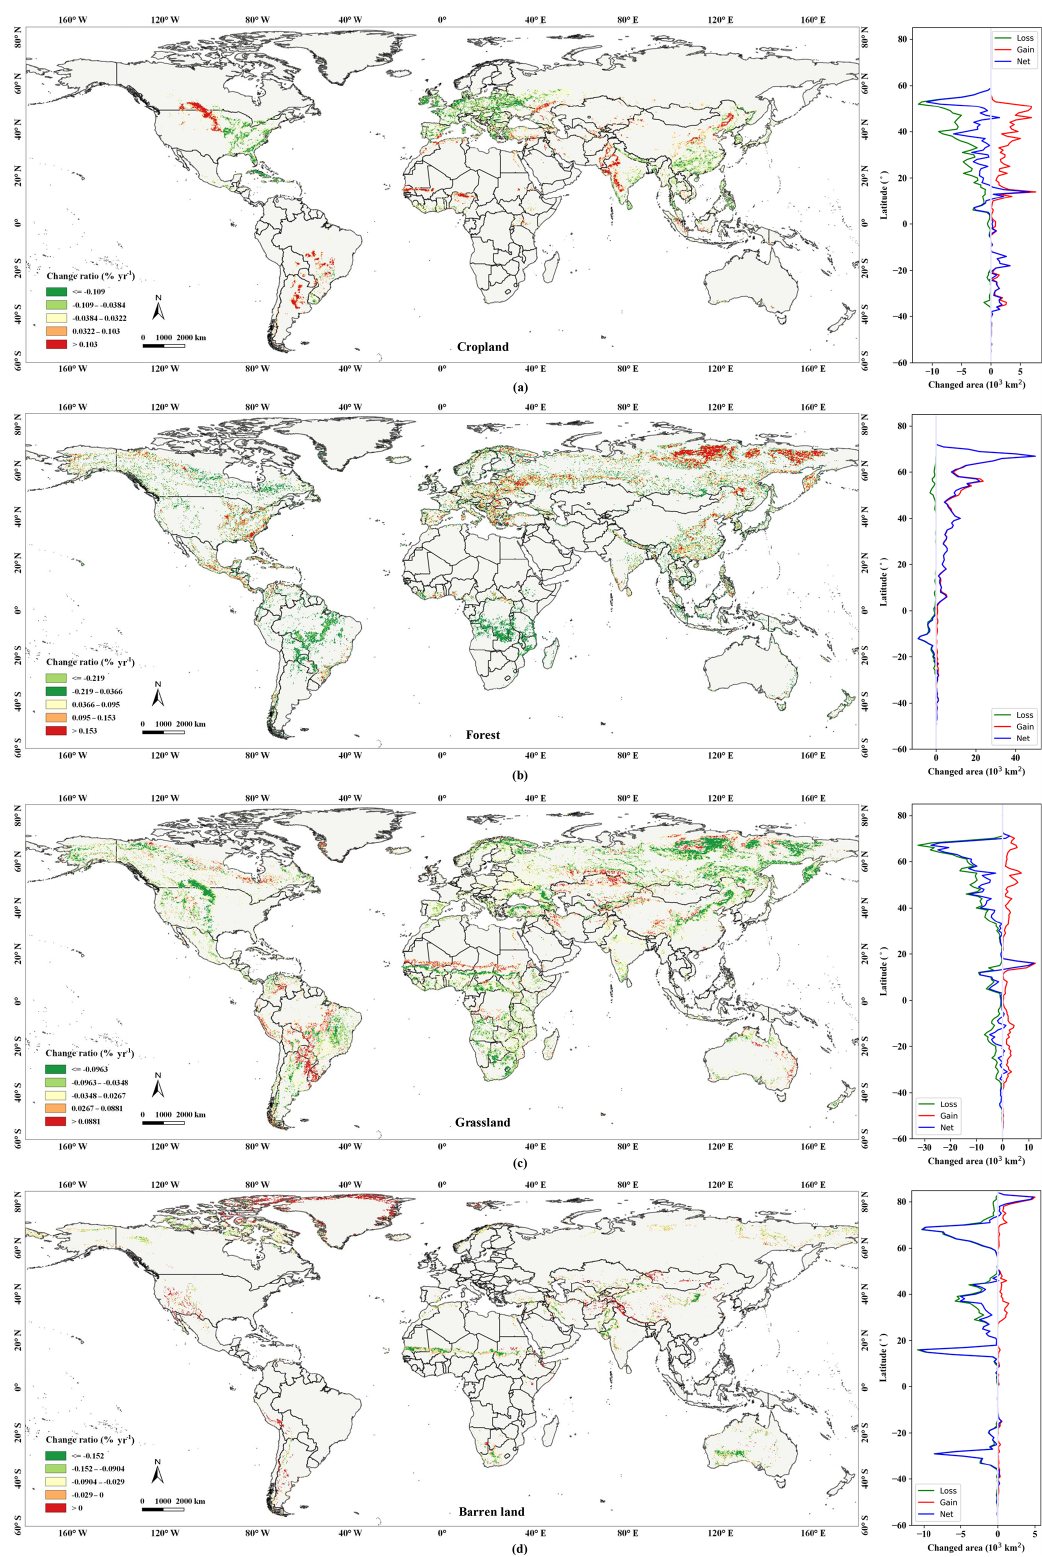
Figure 11. The geographical distribution of global regions with significant land cover change during 1982–2015 and the summarized results along latitudinal gradients for each class: (a) cropland, (b) forest, (c) grassland, and (d) barren